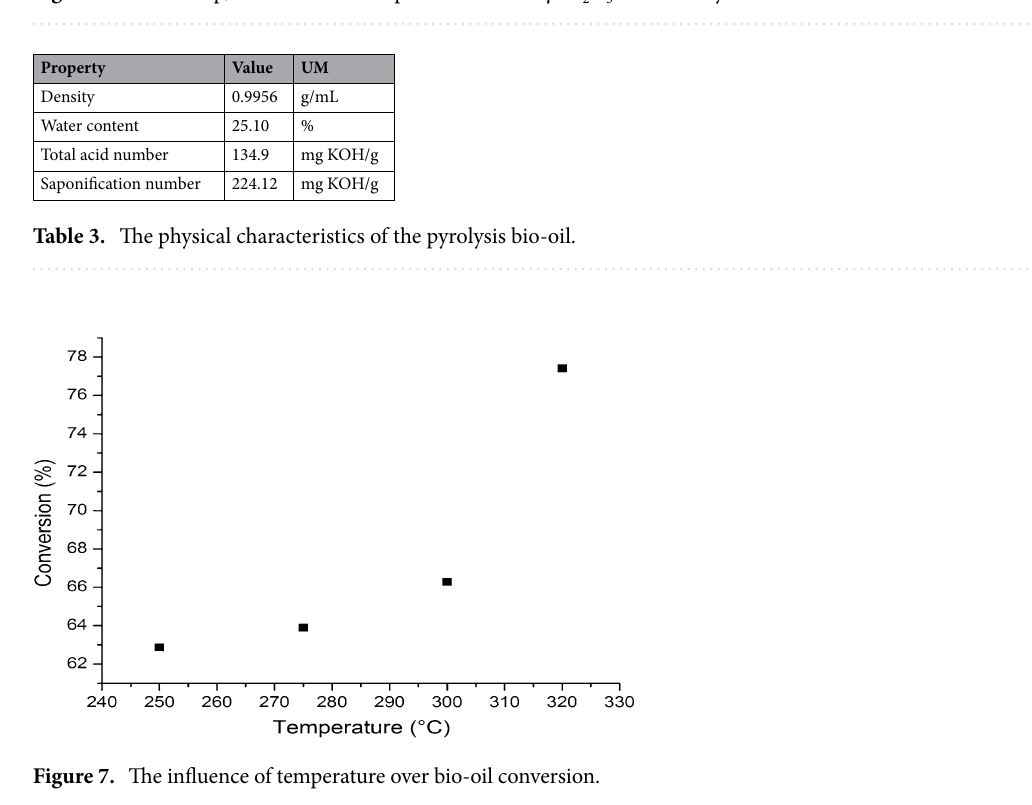
Figure 6. XPS Co 2p, Mo 3d and Si 2 s spectra of CoMo/γ-Al 2 O 3 -HMS catalyst.